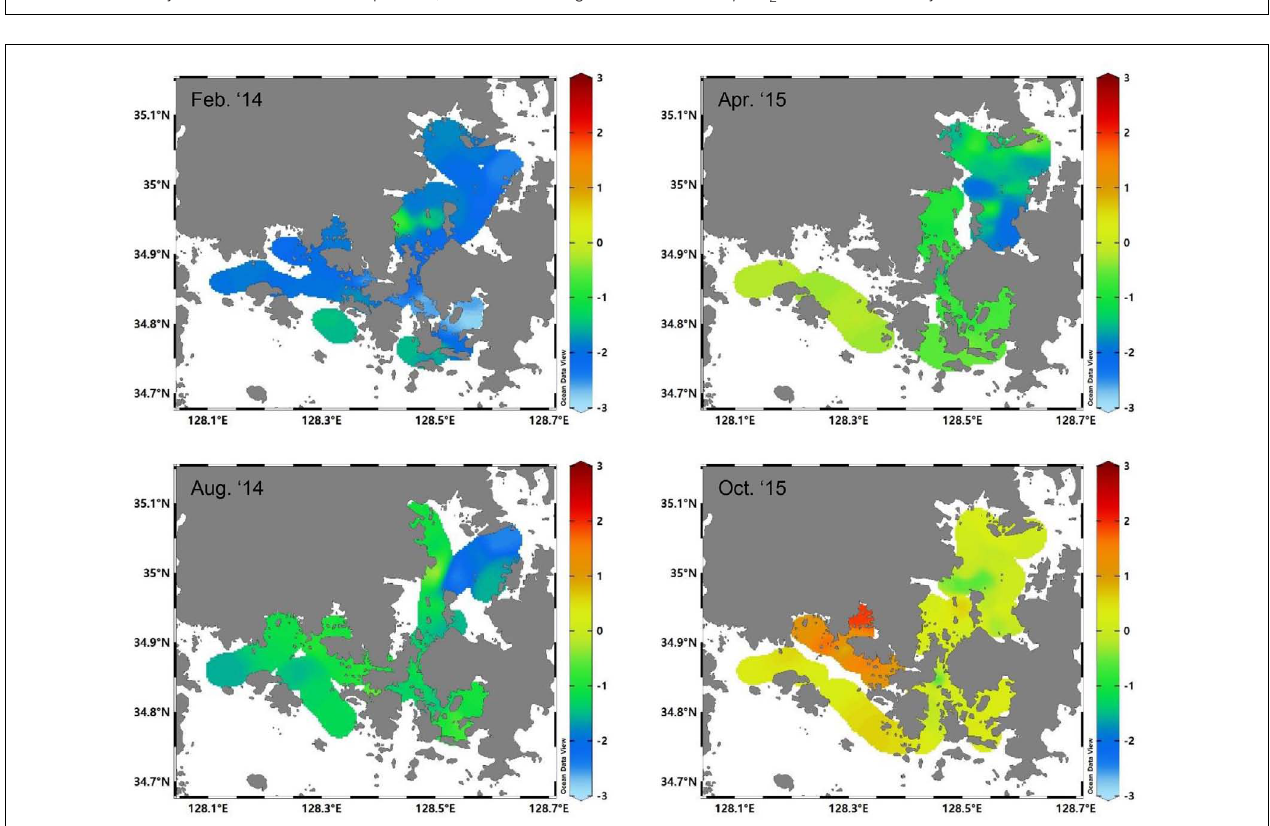
FIGURE 9 | Distributions of air-sea CO 2 exchange flux (mmol m − 2 d − 1 ) for each survey. A positive value indicates a flux direction from sea to air, that is, the sea acts as a CO 2 source, whereas a negative value indicates the